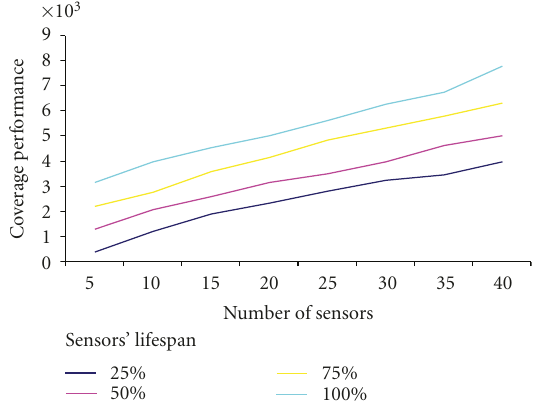
Figure 20: Tradeo ff between sensors’ lifespan and number of sen- sors using